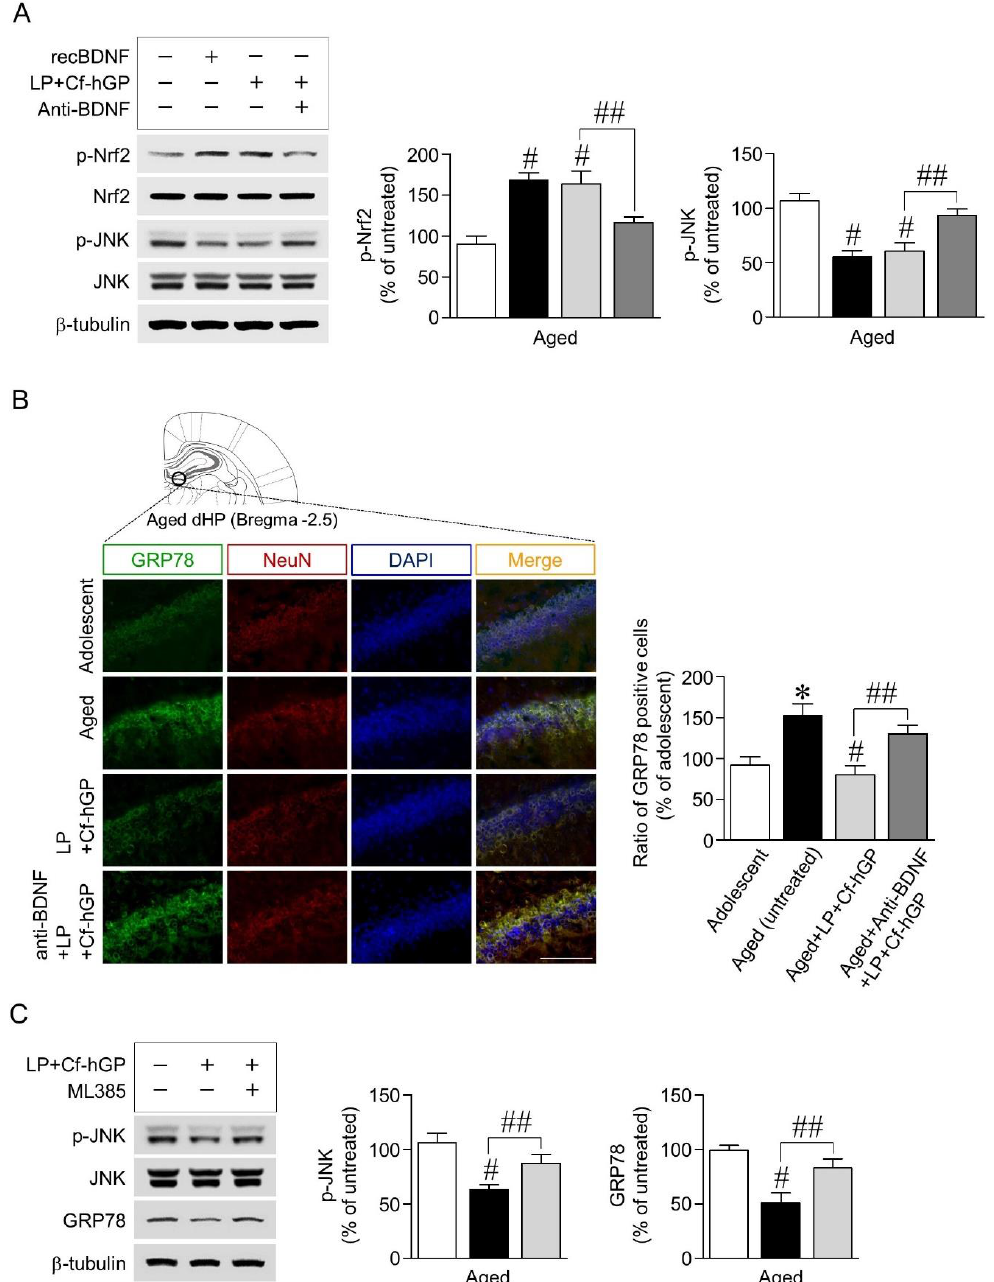
Figure 3. E ff ects of BDNF signaling activated by co-treatment with Cf-hGP and L. plantarum on Nrf2 and JNK phosphorylation and their interactions. The co-treatment-induced increase in Nrf2 phosphorylation was downregulated by functional blocks with the anti-BDNF antibody (1 µ g / µ L) ( A ). According to the double immunofluorescence staining, the co-treatment significantly downregulated the increase in glucose-regulated protein 78 expression in aged rats, which was overturned by blocks with the anti-BDNF antibody (1 µ g / µ L) ( B ). Inhibition of Nrf2 with ML385 (an inhibitor of Nrf2, 100 pmol / µ L) overturned the co-treatment-induced decrease in JNK phosphorylation and GRP78 expression ( C ). * p < 0.05 versus adolescent rats; # p < 0.05 versus aged untreated rats; ## p < 0.05 versus the rats co-treated with Cf-hGP and LP. Cf-hGP, Capsosiphon fulvescens glycoprotein; LP, Lactobacillus plantarum ; recBDNF, recombinant BDNF; dHP, dorsal hippocampus; NeuN, neuronal nuclear antigen; DAPI, 4 (cid:48) ,6-diamidino-2-phenylindole; GRP78, glucose-regulated protein 78. The scale bar represents 100 µ